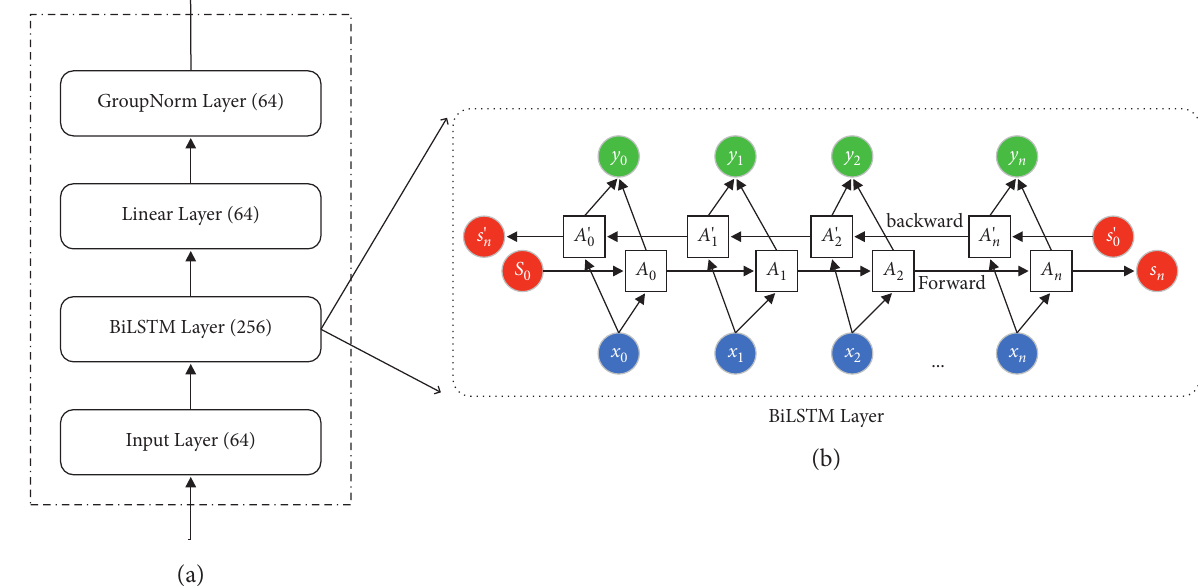
Figure 4: The structure of the BiLSTM block. (a) The module contains BiLSTM, linear, and GroupNorm layers, where the numbers in parentheses indicate the size of the output dimension. (b) The internal structure diagram of the BiLSTM layer, where A refers to the LSTM module, x is the input data, s is the output of the hidden layer, and y is the output result